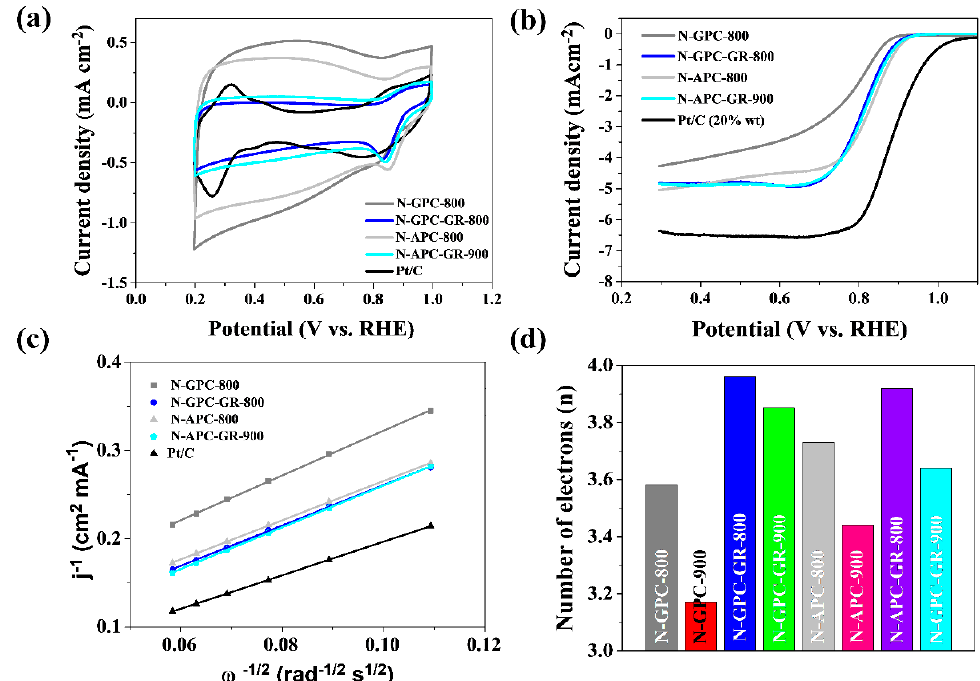
Figure 9. Results of catalyst activity in the oxygen reduction reaction for N–rich–derived carbons and the Pt/C catalyst. ( a ) CV curves of electrocatalysts in an O 2 –saturated 0.1 M KOH solution, ( b ) LSV of various electrocatalysts on RDE measured at a scanning speed of 5 mV s − 1 and a rotation speed of 1600 rpm, ( c ) Koutecky–Levich plot at 0.5 V, ( d ) number of transferred electrons. Adapted from [160], with permission from Scientific Reports , 2021.